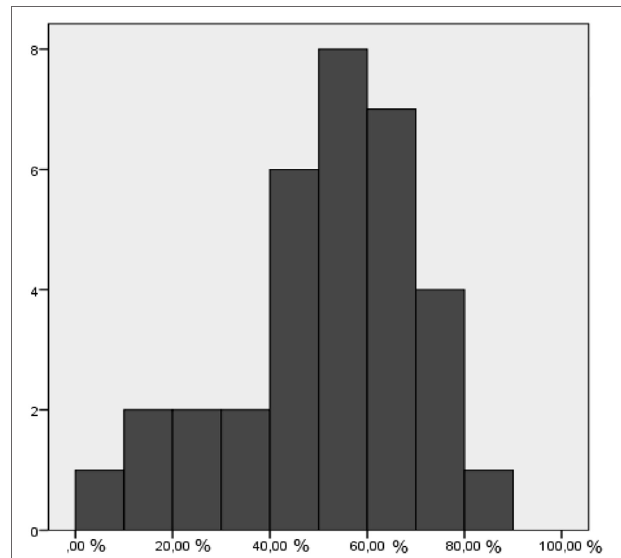
FigUre 2 | % of GTV PETMRI covered by high dose in whole study